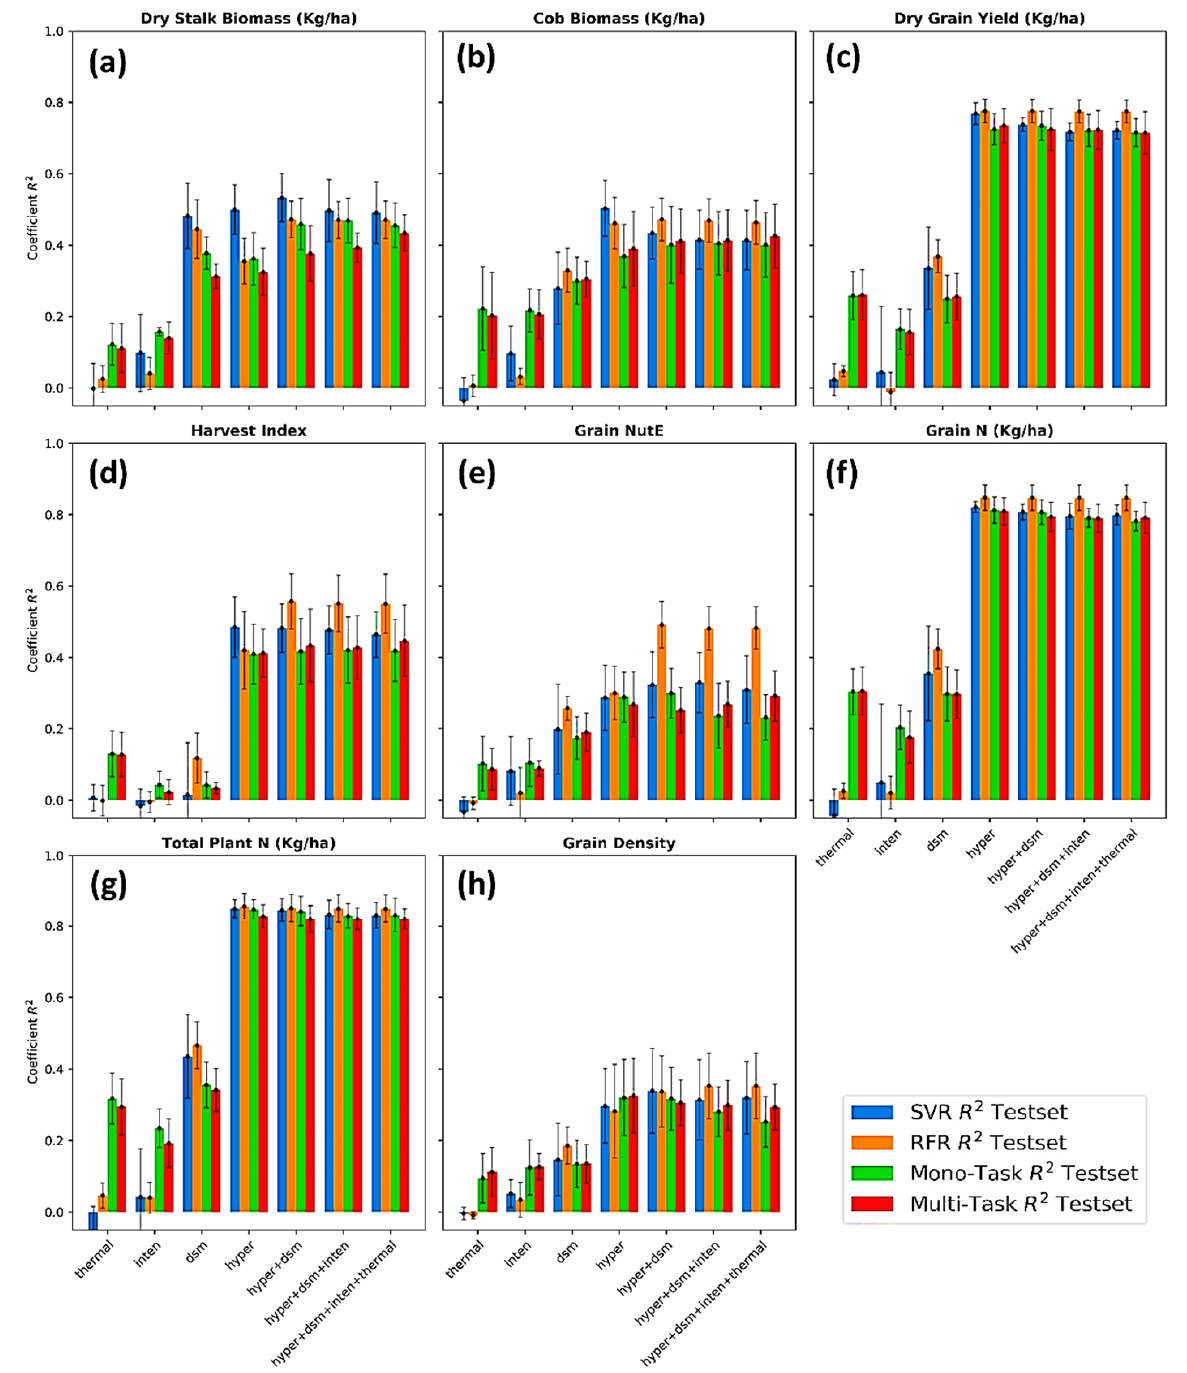
Figure 8. Prediction performance of eight maize phenotypes ( a – h ) represented by R 2 across different feature types and regressors. Feature types included thermal = canopy thermal, inten = LiDAR canopy intensity, dsm = LiDAR canopy height, hyper = hyperspectral images. Feature fusions included hyper + dsm = a fusion of hyperspectral and LiDAR canopy height, hyper + dsm + inten = a fusion of hyperspectral, LiDAR canopy height, and LiDAR canopy intensity, and hyper + dsm + thermal = a fusion of hyperspectral, LiDAR canopy height, LiDAR canopy intensity, and thermal.